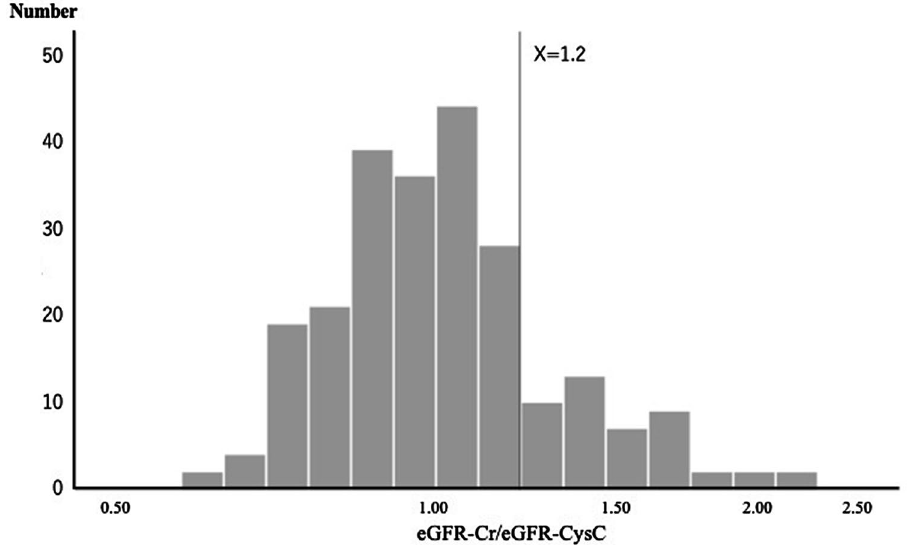
Figure 2. Distribution of eGFR-Cr/eGFR-CysC using the histogram with a logarithmic scale on the X axis. eGFR-Cr; estimated glomerular filtration rate using creatinine. eGFR-CysC; estimated glomerular filtration rate using cystatin C. There was an inflection point at 1.2. Thus, we divided the patients into two groups by this point (greater than 20%